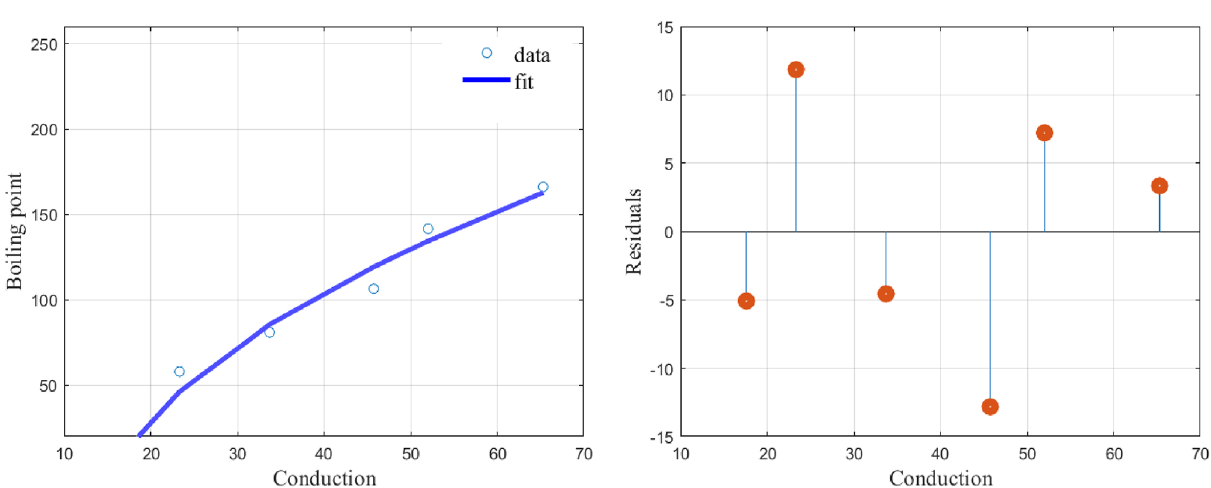
Figure 6. Shows the model fit and the